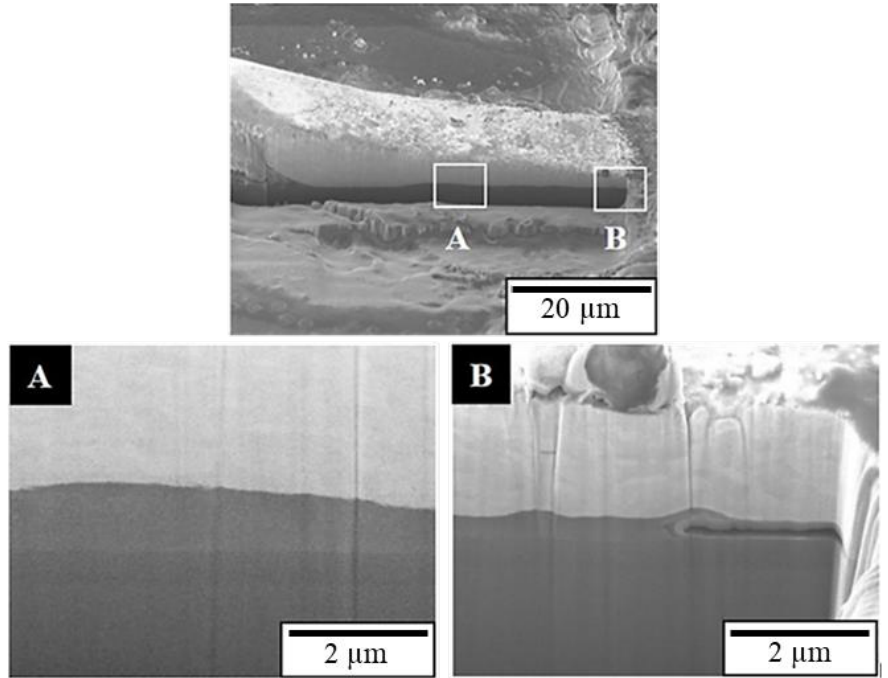
Figure 12. FIB cross-section of the second bond of the APAP wire after 30 min of chlorination. ( a ) Smooth interface; ( b ) aluminum film at the edge is eroded and hollowed out.